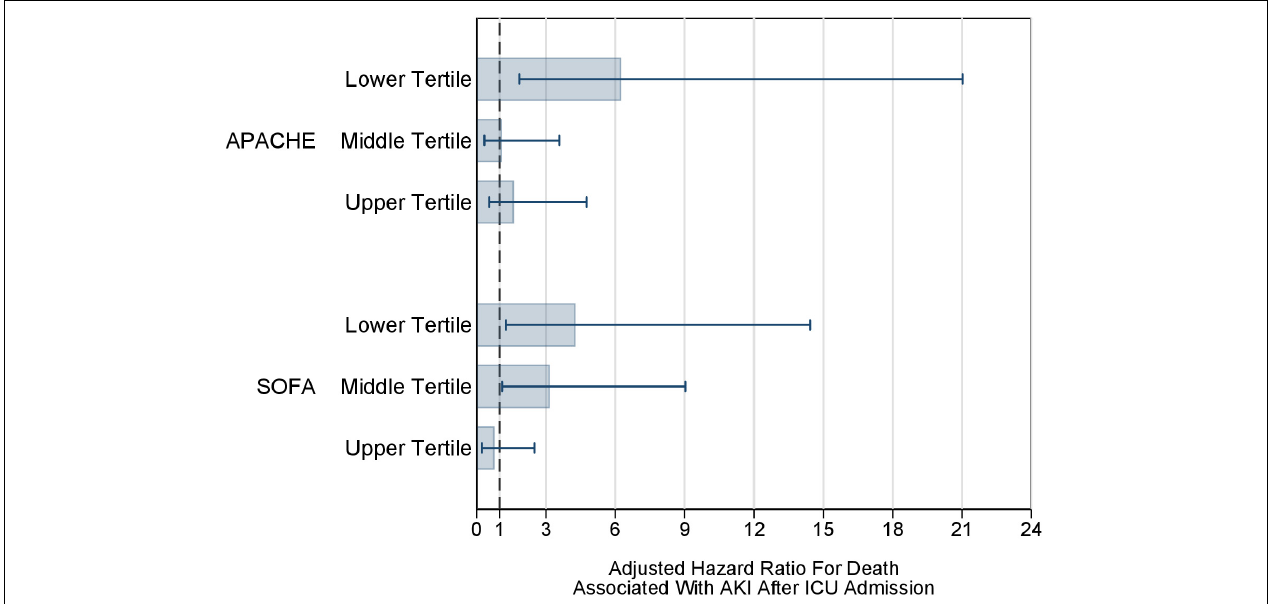
FIGURE 3 | Multivariable adjusted AKI-associated risk of death in the ICU across tertiles of SOFA or APACHE II score. Multivariable-adjusted hazard ratio of death associated with AKI during ICU stay, stratified for each tertile of the SOFA (lower part) or APACHE II (upper part) score at ICU admission. The shaded bars represent the adjusted hazard ratio, the horizontal lines represent 95% CI. Horizontal lines crossing the dotted vertical line indicate that the hazard ratio was not statistically significant. AKI, acute kidney injury; APACHE II, Acute Physiology and Chronic Health Evaluation II; ICU, intensive care unit; SOFA, Sequential Organ Failure